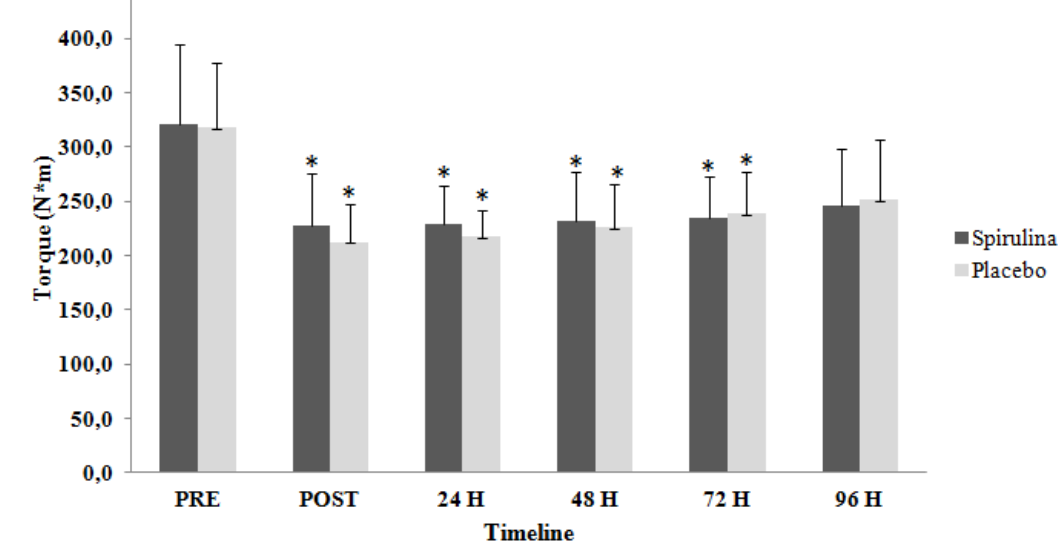
Figure 1. Change of eccentric peak torque for both limbs in response to eccentric protocol. PRE, Baseline measurement; H, Hours; * Significant difference with PRE.